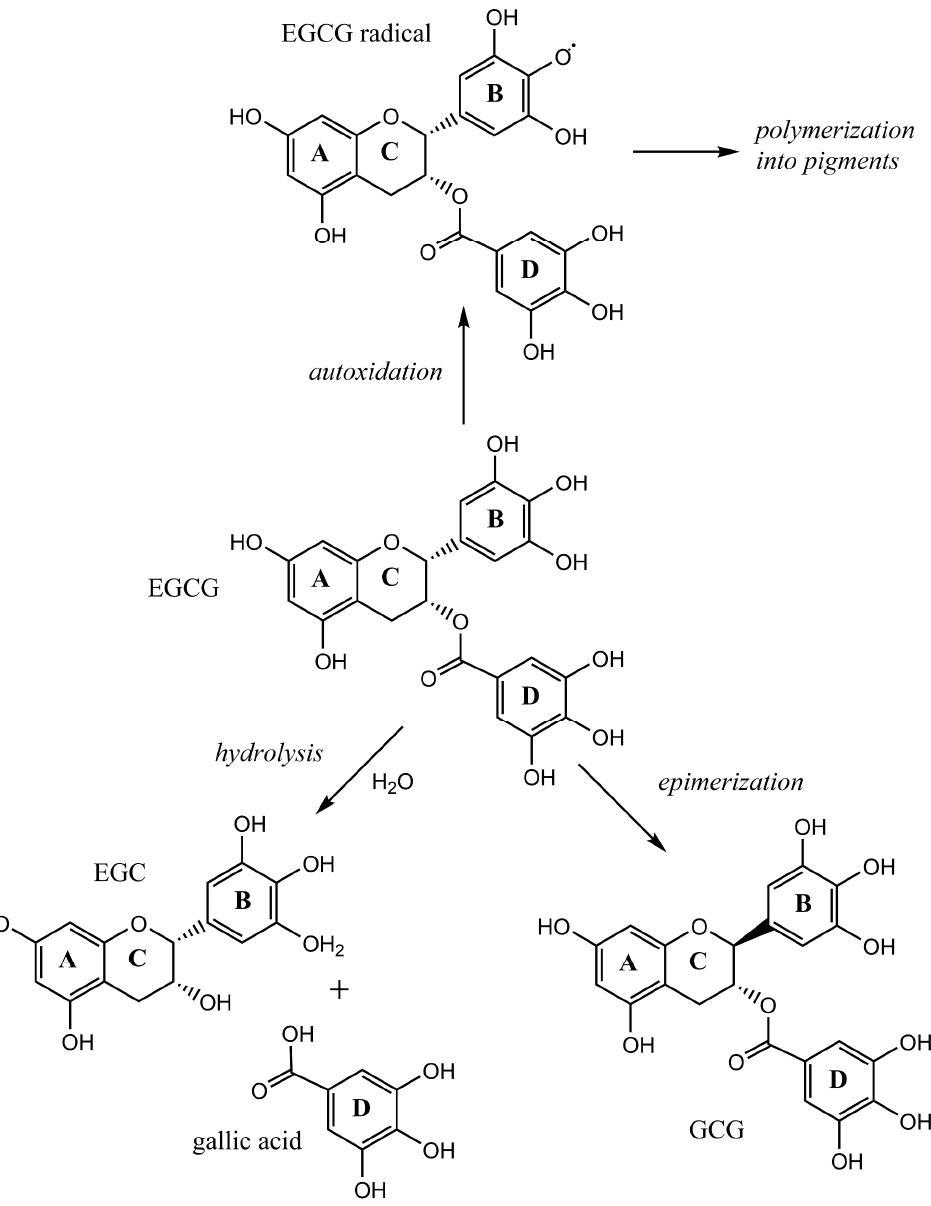
Figure 6. Chemical reactions that change green tea catechin content and composition.